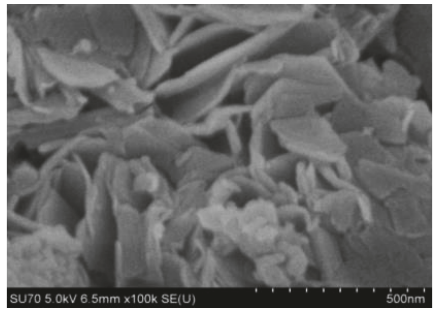
Figure 8: SEM of cement paste mixed with 2%NO 2 -